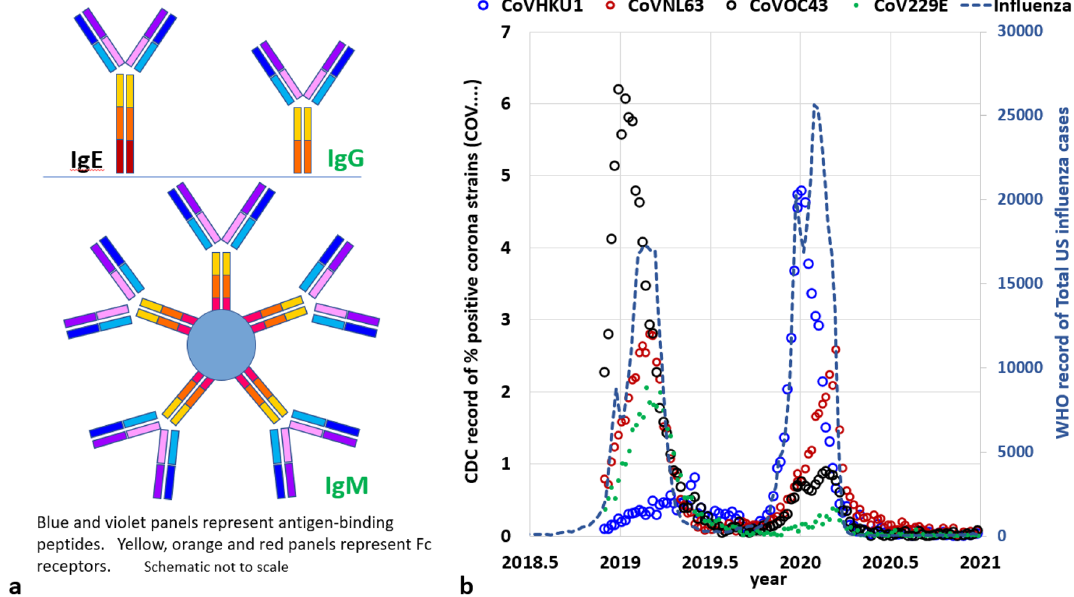
Figure 5. ( a ) Antibody epitope compositions and geometries (not to scale) ( b ) Historical records for the US of 4 separate coronavirus strains (Source: CDC 42 ) and all influenza strains (Source WHO 43